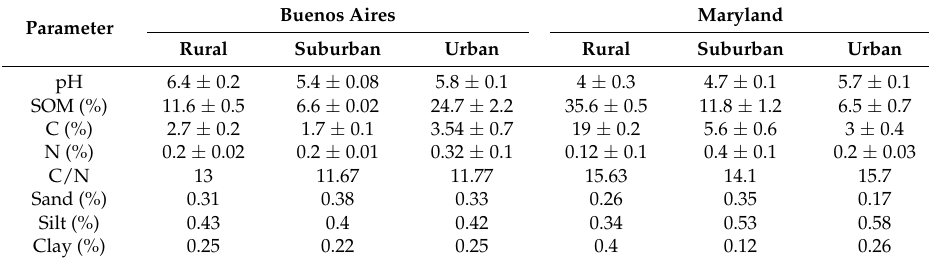
Table 1. Soil characteristics for the urban, suburban, and rural sites within each area. Results are arithmetic means ± standard errors, except for texture results that are shown as percent values per